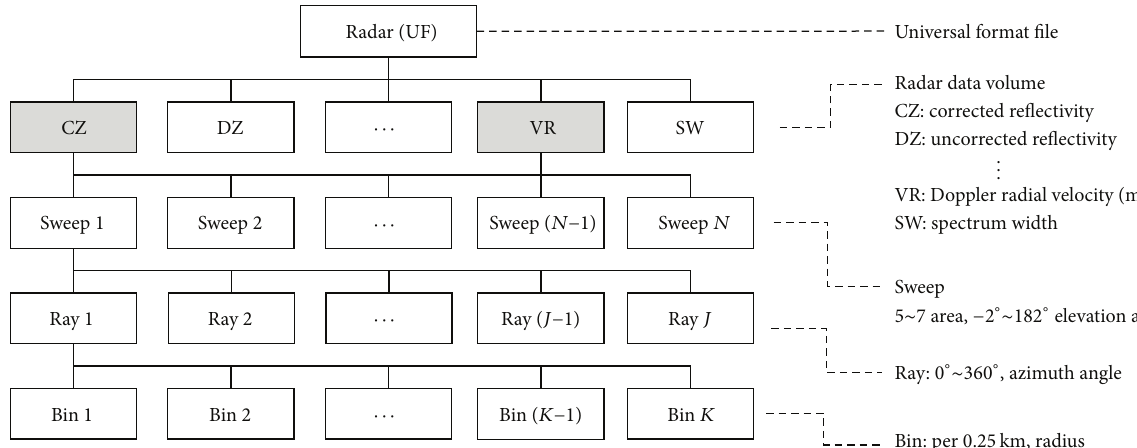
Figure 1: Radar data